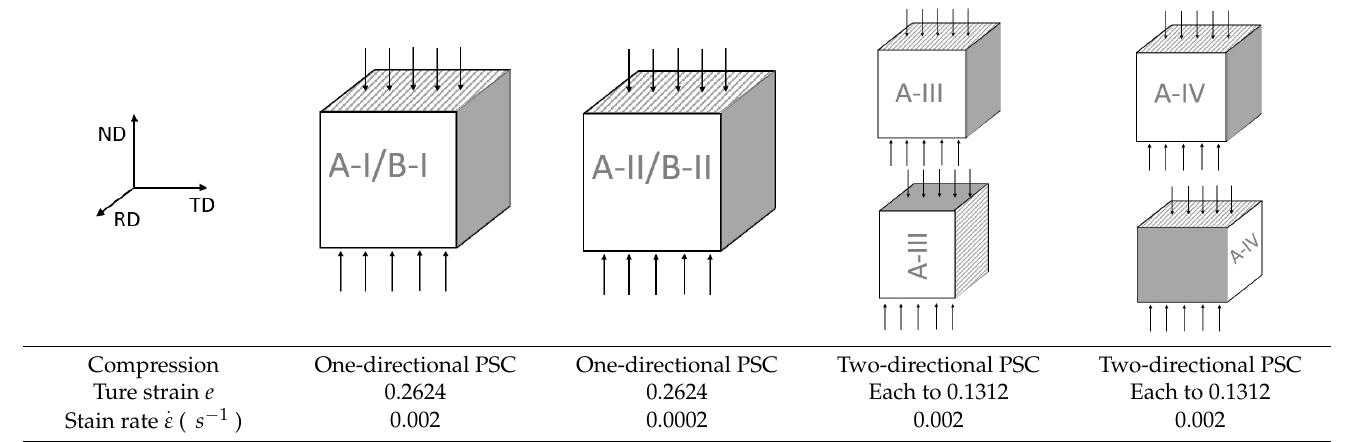
Figure 2. Schematic of a channel die testing rig with sample compressed in plane strain condition.